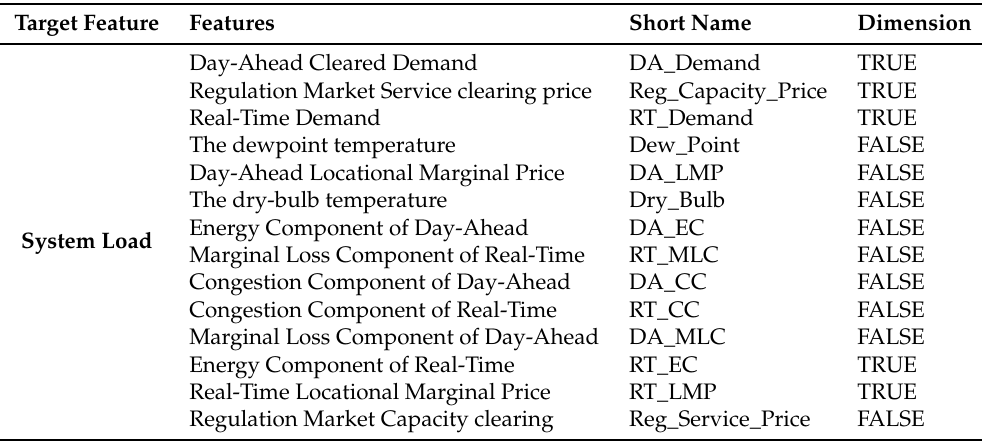
Table 1. Features Overview and Dimensions calculated by Redundacny removal using Feature Extraction (RFE).